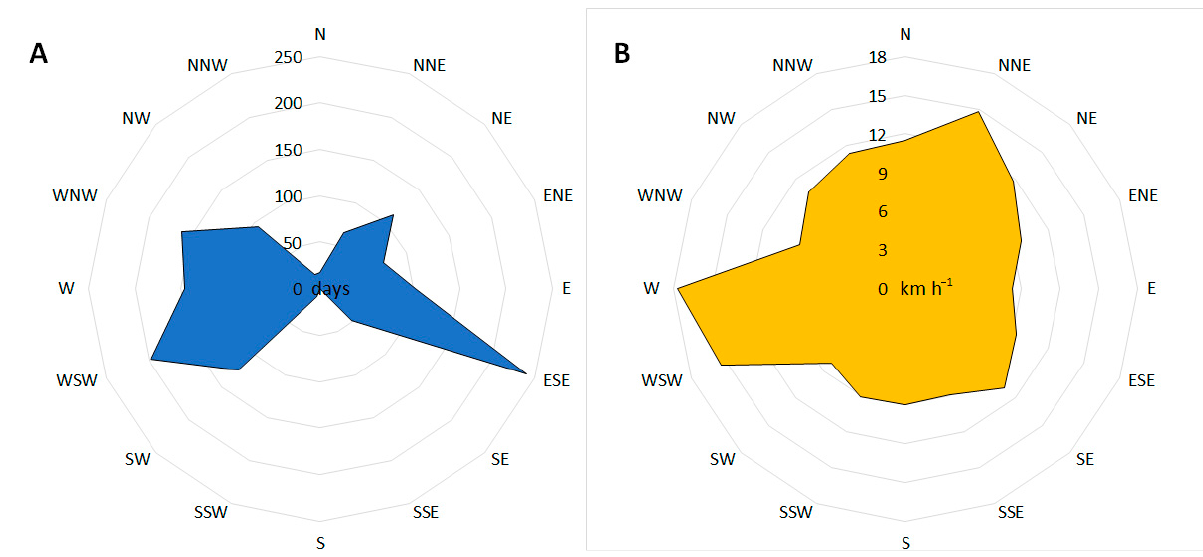
Figure 2. ( A ) Days of dominant wind directions during the four study years between 2016 and 2019. ( B ) Average wind speed (km h − 1 ) in each of the directions.